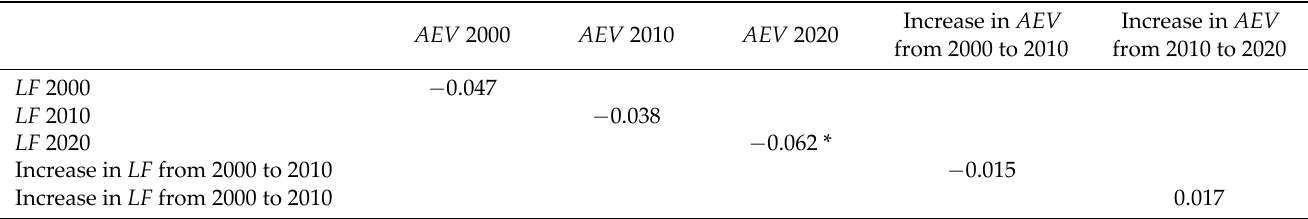
Table 3. Pearson’s correlation between LF and AEV